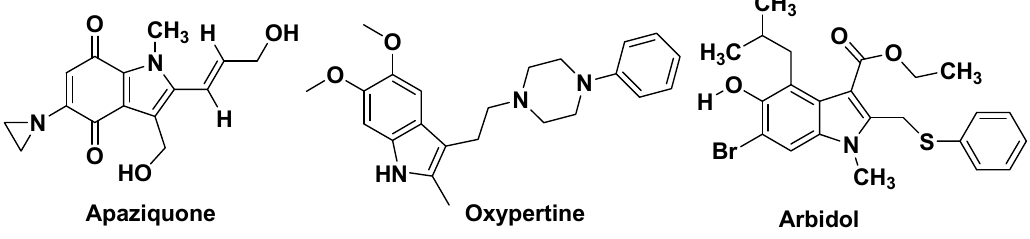
Figure 10. Apaziquone as anticancer, Oxypertine as antipsychotic and Arbidol as